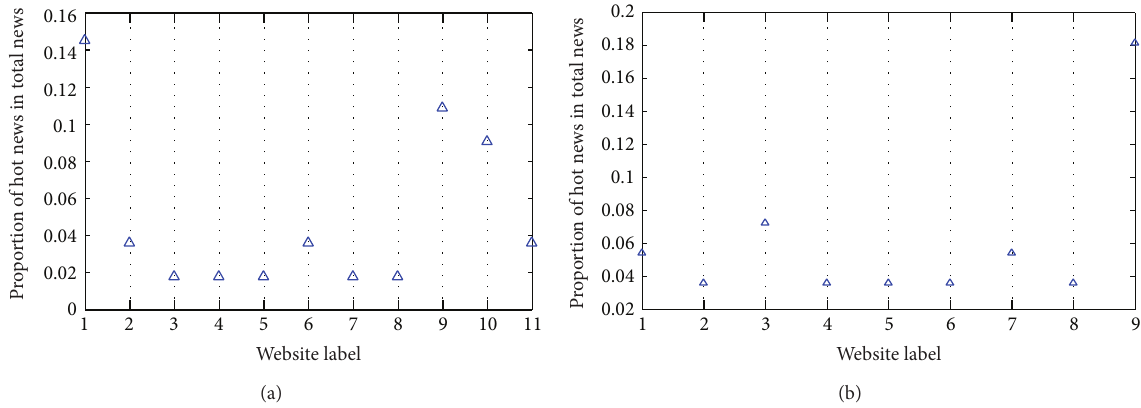
Figure 3: Proportion of news from different news websites ((a) December 1; (b) December 2).